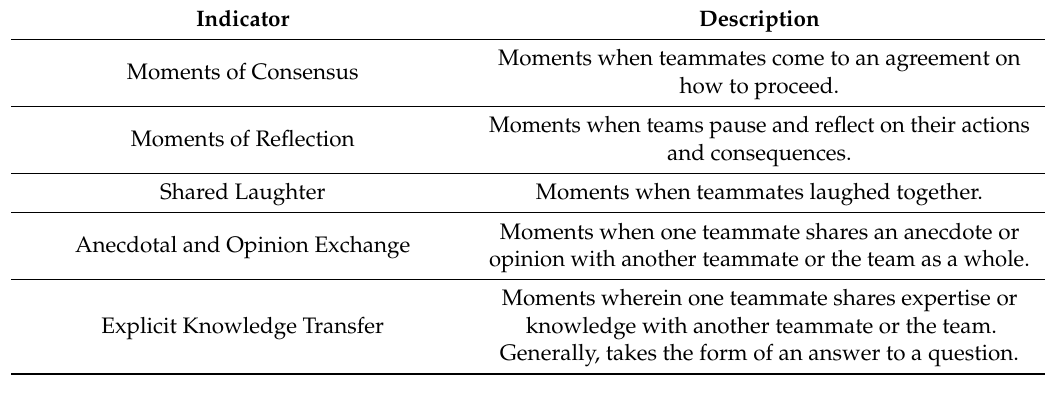
Table 5. Quality of interaction indicators and descriptions.